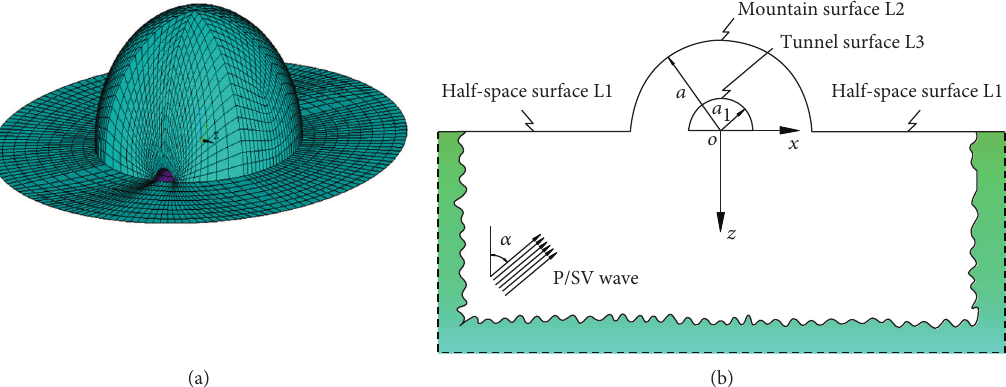
Figure 1: The physical model of scattering of elastic waves by a 3D tunnel mountain. (a) Surface discretization. (b) Profile perpendicular to the tunnel